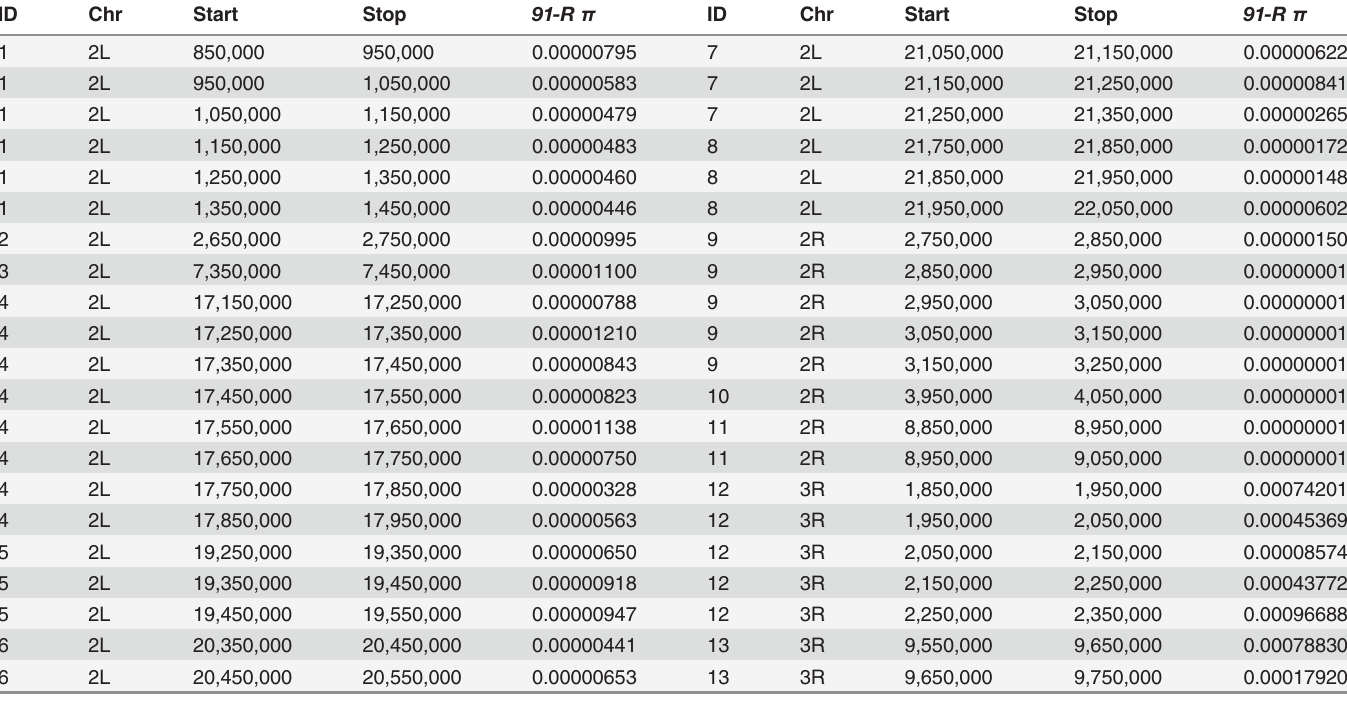
Table 2. Thirteen genomic intervals in Drosophila melanogaster strain 91-R (ID 1 to 13) with nucleotide diversity estimated reduced (cid:1) 100-fold compared to respective chromosome means, and indicate putative genome regions under directional selection for survival when exposed to